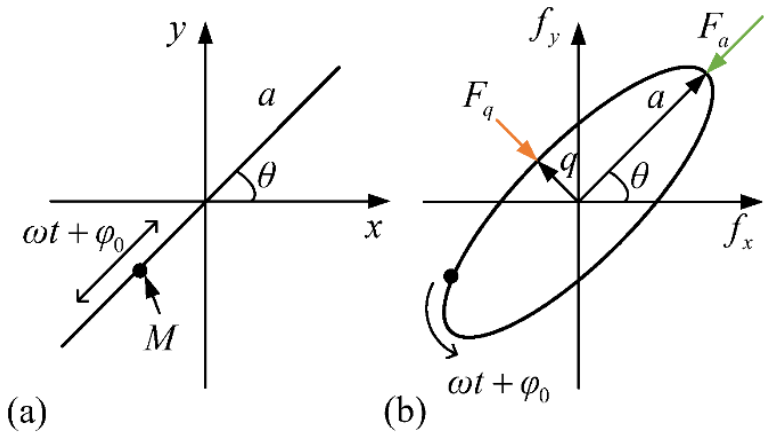
Figure 1. ( a ) Ideal and ( b ) non-ideal vibration patterns of the gyro.